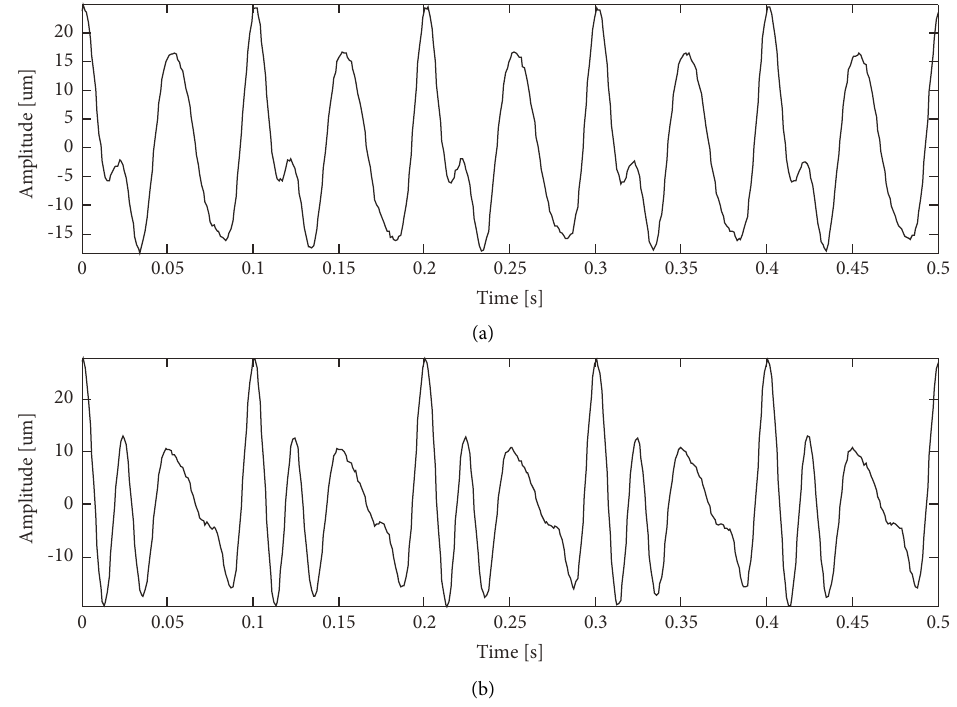
Figure 4: Time curves corresponding to the two observed signals.